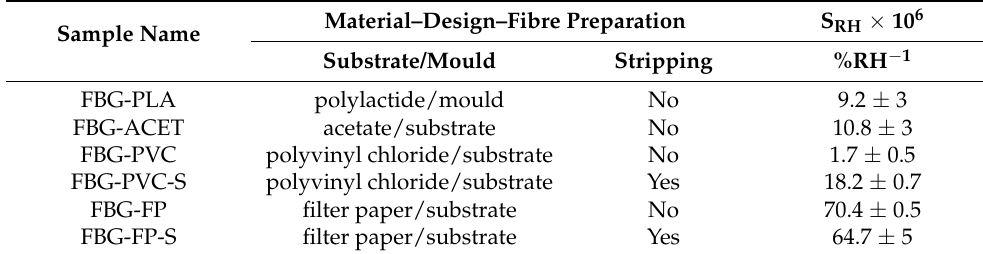
Table 1. List of the samples.